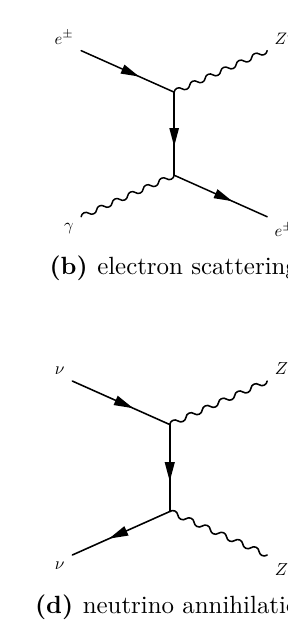
Figure 1. The Feynman diagrams relevant for the Z 0